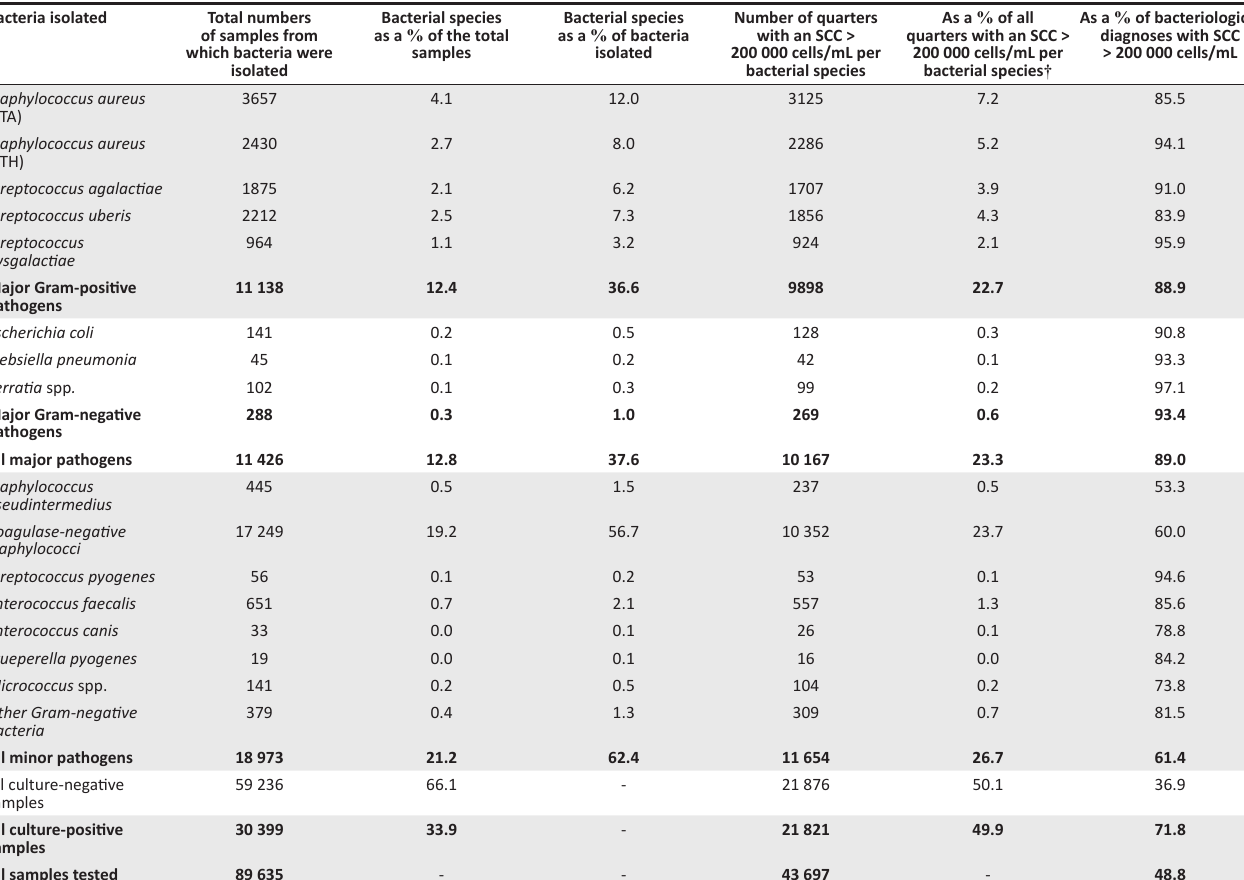
TABLE 1: Bacteriologically negative and positive quarter milk samples indicating pathogen-specific bacteria and groups isolated from samples with and without somatic cell counts above 200 000 cells/mL milk. Bacteria isolated Total numbers of samples from which bacteria were